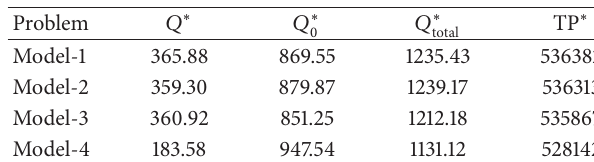
Figure 6: Effect of budget 𝐵 for different values of 𝛽 0 on the total profit. Table 1: The optimal results of the models.